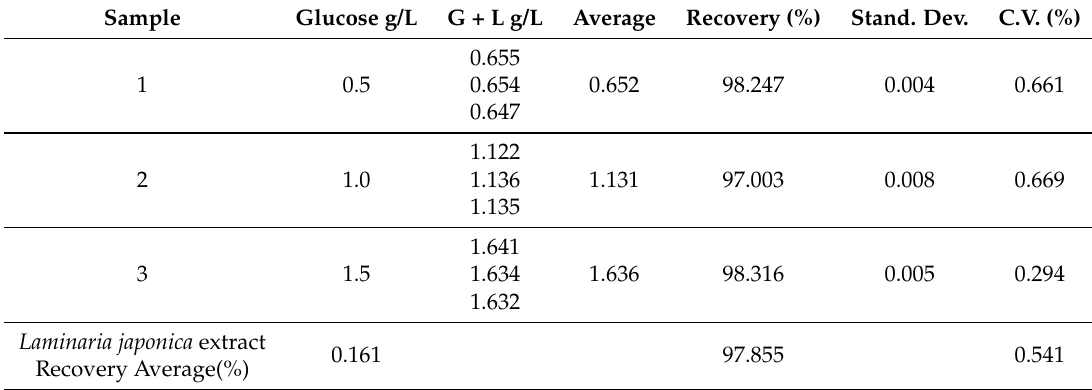
Table 4. Recovery rate and coefficient of variation for glucose sample (G) + Laminaria japonica extract (L). Sample